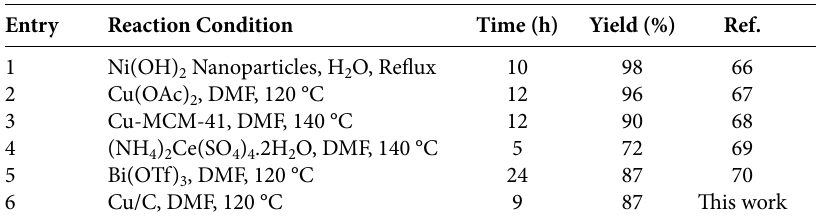
Table 3: Comparison between the efficiency of Cu/C as catalyst and some other catalysts for the synthesis of 5-substituted 1 H -tetrazole derivatives. Entry Reaction Condition Time (h) Yield (%) Ref.